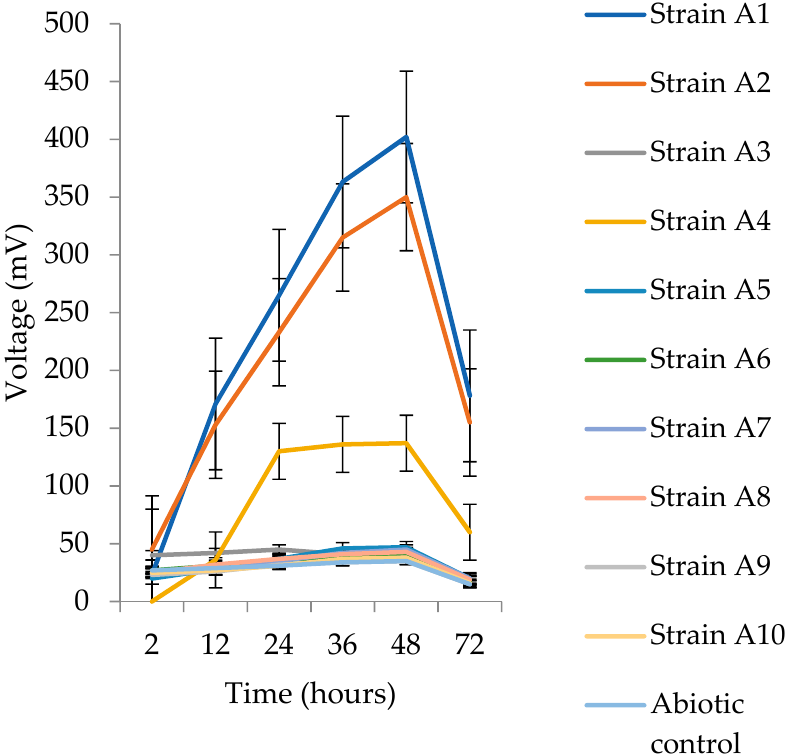
Figure 5. Testing pure bacterial cultures isolated from single-chambered MFC with poultry wastewater in double-chambered MFC for electricity generation for 72 h.